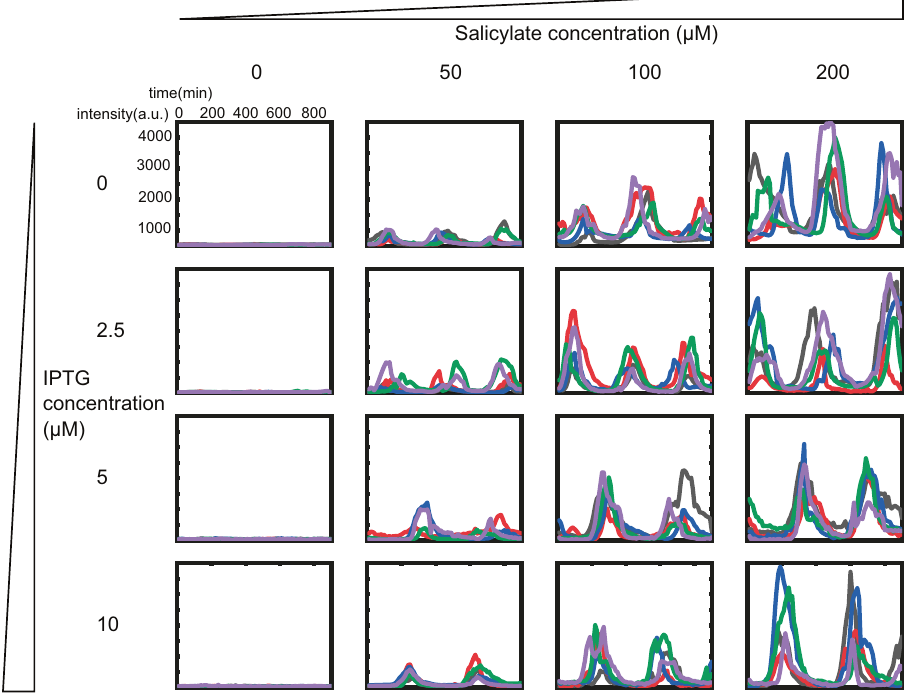
Fig. 3 Typical curves of the independent regulation of the repressilator circuit. The concentration of IPTG had a gradient of 0, 2.5, 5, 10 μ M and the salicylate had a gradient of 0, 50, 100, 200 μ M. Five typical fl uorescence intensity curves of mother cells for each group are shown. The curves were re- plot to ensure the alignment of the